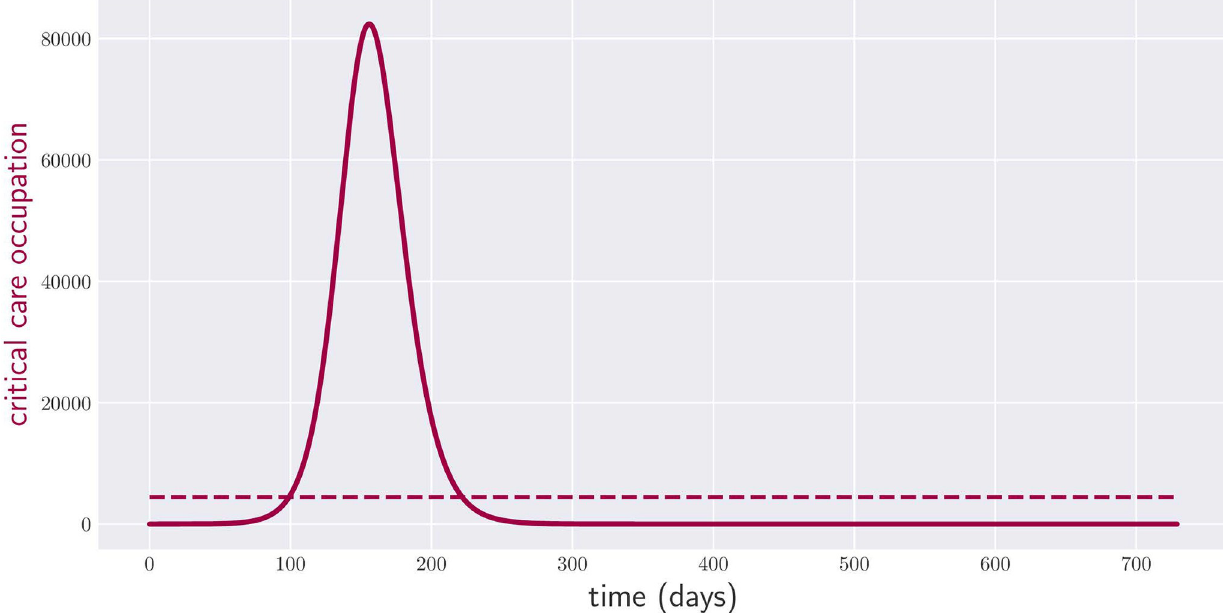
Fig 2. Occupation of critical care beds over two years with no policy intervention. The red dashed line indicates the critical care capacity of the healthcare system.